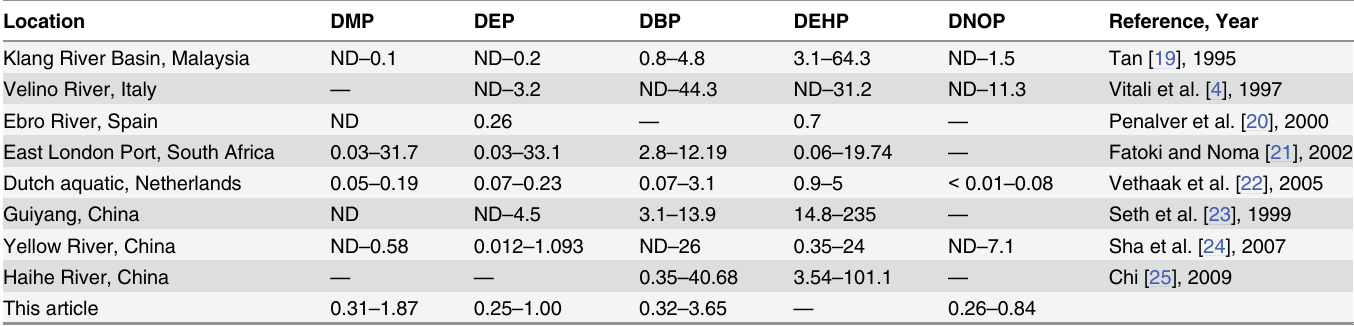
Table 2. Concentrations of the six target PAEs in water compared with other studies ( μ g L − 1 ).